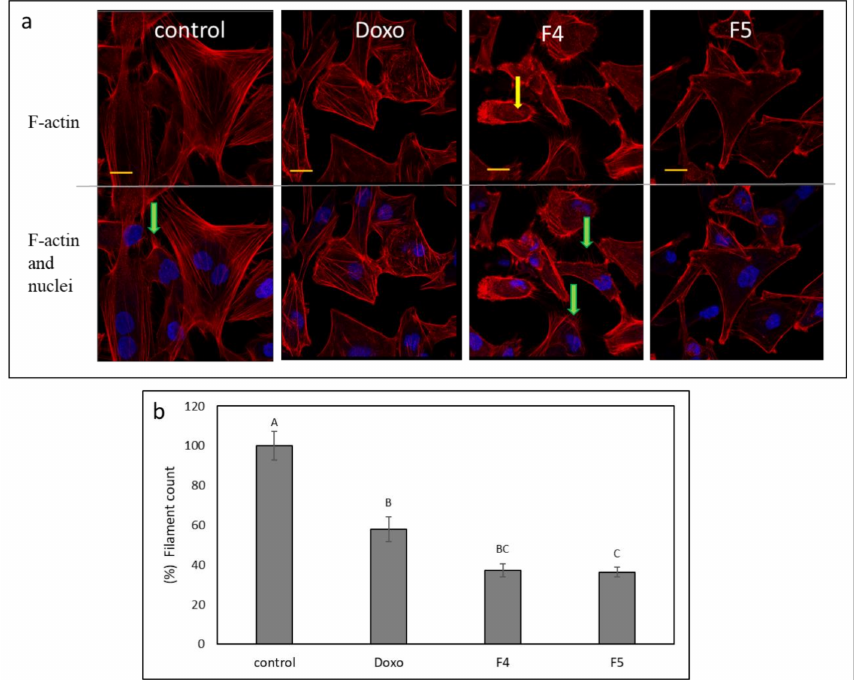
Figure 8. ( a ) Representative examples of confocal images of A172 cells following treatment with F4 (12 µ g/mL) and F5 (10 µ g/mL) for 24 h. F-actin (EasyProbes™ ActinRed 555 Stain, red stain) and nuclei (Hoechst, blue stain) were stained. Control is vehicle control (1.15% v / v methanol). Doxorubicin (Doxo, 0.5 µ g/mL) served as a positive control. Scale bars = 20 µ m; n = 3. Yellow arrows point to the disintegration of F-actin filaments visualized as characteristic spots; green arrows show F-actin filopodia protruding from cells. ( b ) The number of F-actin filaments that crossed a line drawn across the soma in each of the treatments. The percent number of filaments is presented as mean; error bars indicate ± SE ( n = 5). Levels with different letters are significantly different from all combinations of pairs according to the Tukey–Kramer honest significant difference (HSD; p ≤